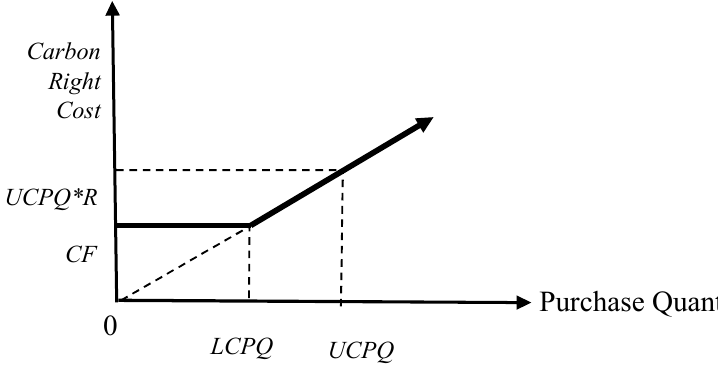
Figure 5. Carbon right cost.